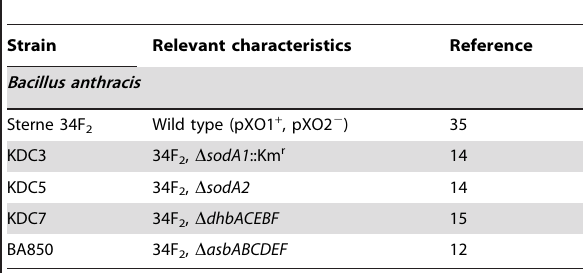
Table 5. Bacterial strains used in this